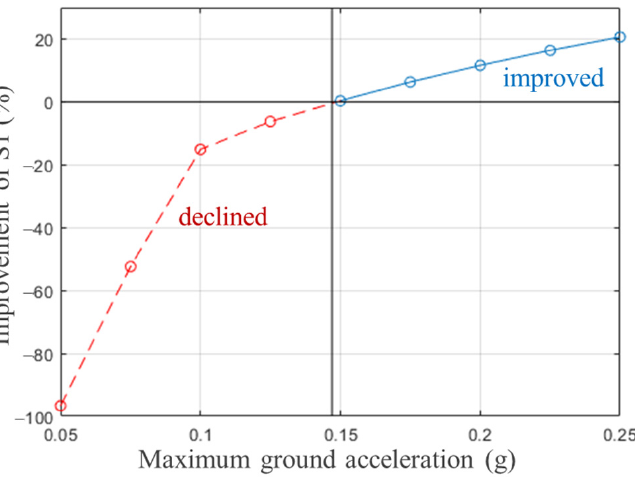
Figure 12. Improvement of case S1 in energy dissipation from the initial shape analyzed with the dynamic optimization model.